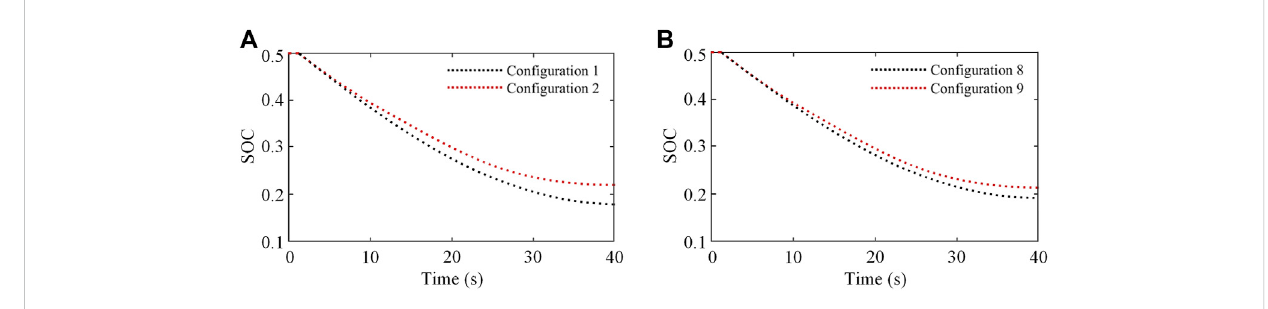
FIGURE 6 SOC curves under (A) scenario 1 and (B) scenario 2.